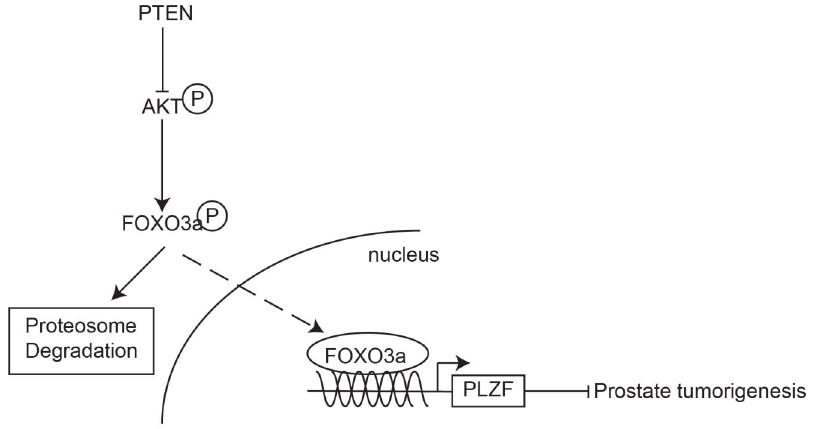
Figure 7. The putative PTEN/FOXO3a/PLZF signaling pathway in the development of prostate cancer.